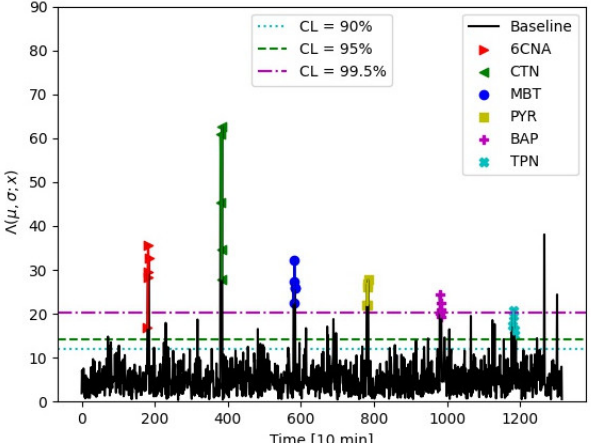
Figure 4. Anomaly estimator for a synthetic time series created based on the test set.